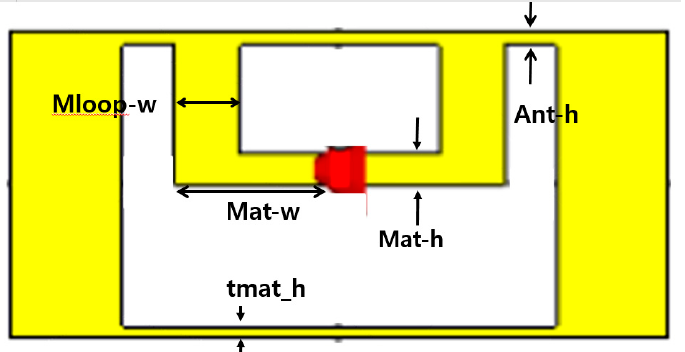
Figure 4. Parameters of the Radio Frequency Identification (RFID) tag antenna in Figure 3 enlarged and rotated clockwise 90 degrees.